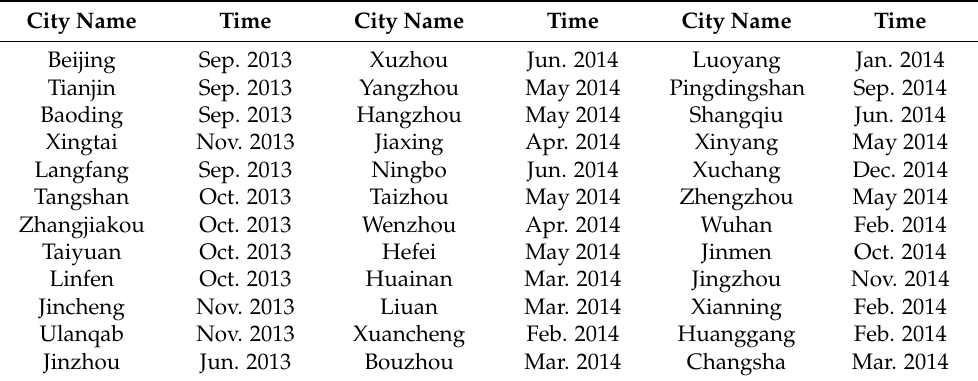
Table 1. Implementation time of AP2013 in some